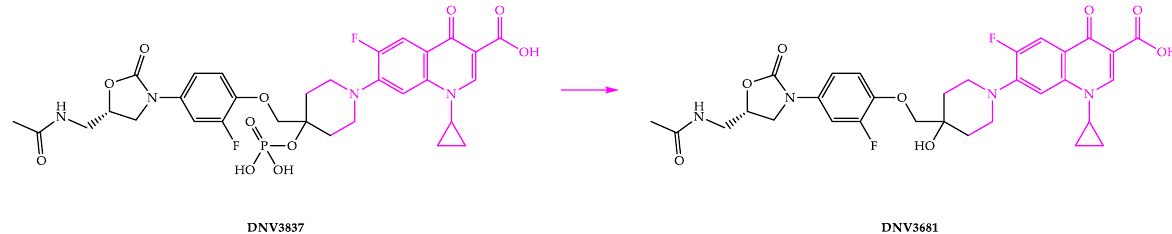
Figure 7. Chemical structures of DNV3837 and DNV3681.